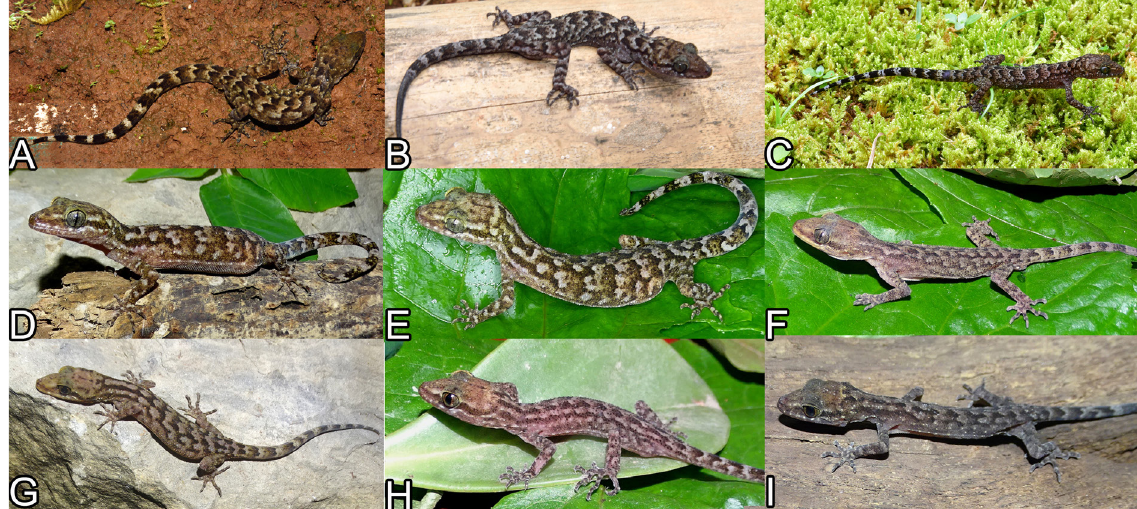
Fig. 3. Cyrtodactylus exercitus sp. nov. in life ( A . MZMU2542. B . MZMU2543. C . MZMU2545); Cyrtodactylus siahaensis sp. nov. in life ( D . MZMU2443. E . MZMU2444. F . MZMU2445. G . MZMU2446. H . MZMU2449. I .